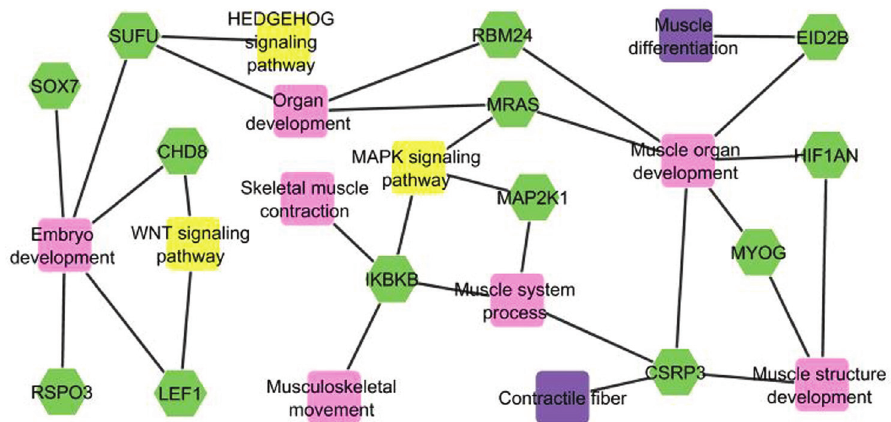
Figure 1 - Functional gene networks and their interactions, showing the relationship between 13 genes (green). Twelve important subnets related to mus- cle development were included in biological process (pink), molecular function (violet) and metabolic pathway (yellow).